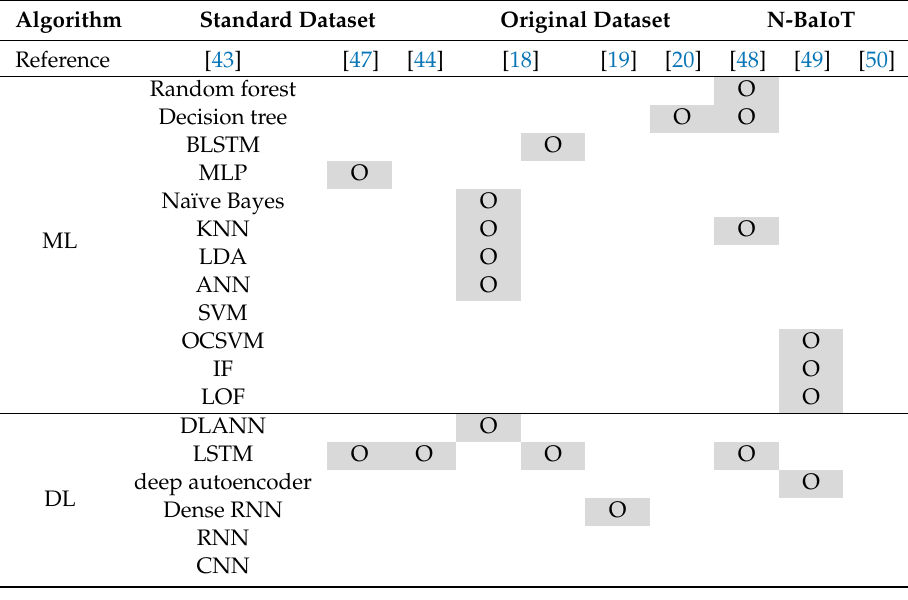
Table 3. Dataset(s) and algorithm(s) used in each